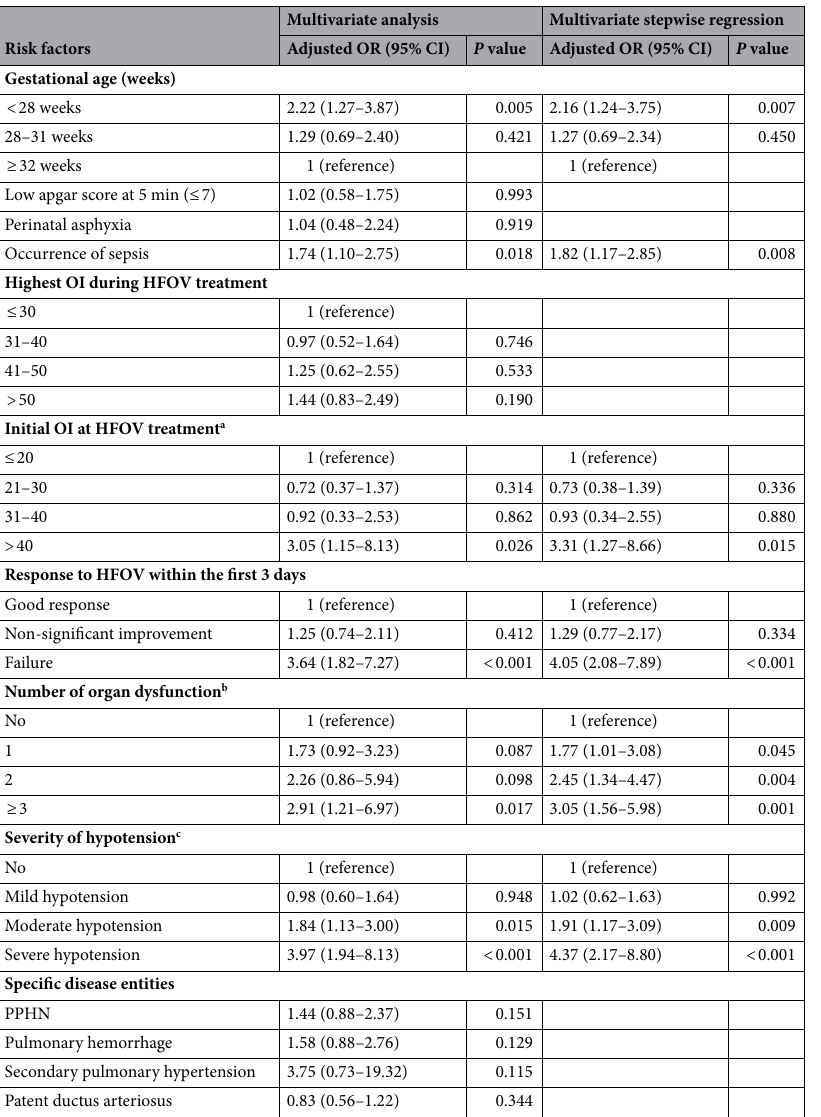
Table 4. Risk factors for final in-hospital mortality by multivariate analysis and multivariate stepwise analysis. OI: oxygenation index; RDS: respiratory distress syndrome; PPHN: persistent pulmonary hypertension of newborn; OR: odds ratio, 95% CI: 95% confidence interval. a The average oxygenation index at 2 and 6 h after initiation of HFOV was used. b Number of organ dysfunction: including neurological, renal, hematological, and hepatic dysfunction. c Mild hypotension was defined as patients who required only one cardioinotropic agents (usually dopamine < 10 µg/kg/min); Moderate hypotension was defined as patients who required both dopamine and dobutamine, with only one of them ≥ 10 µg/kg/min to maintain adequate blood pressure; Severe hypotension was defined as patients who required epinephrine and/or more than two cardioinotropic agents (usually dopamine and dobutamine, both ≥ 10 µg/kg/min) to maintain adequate blood